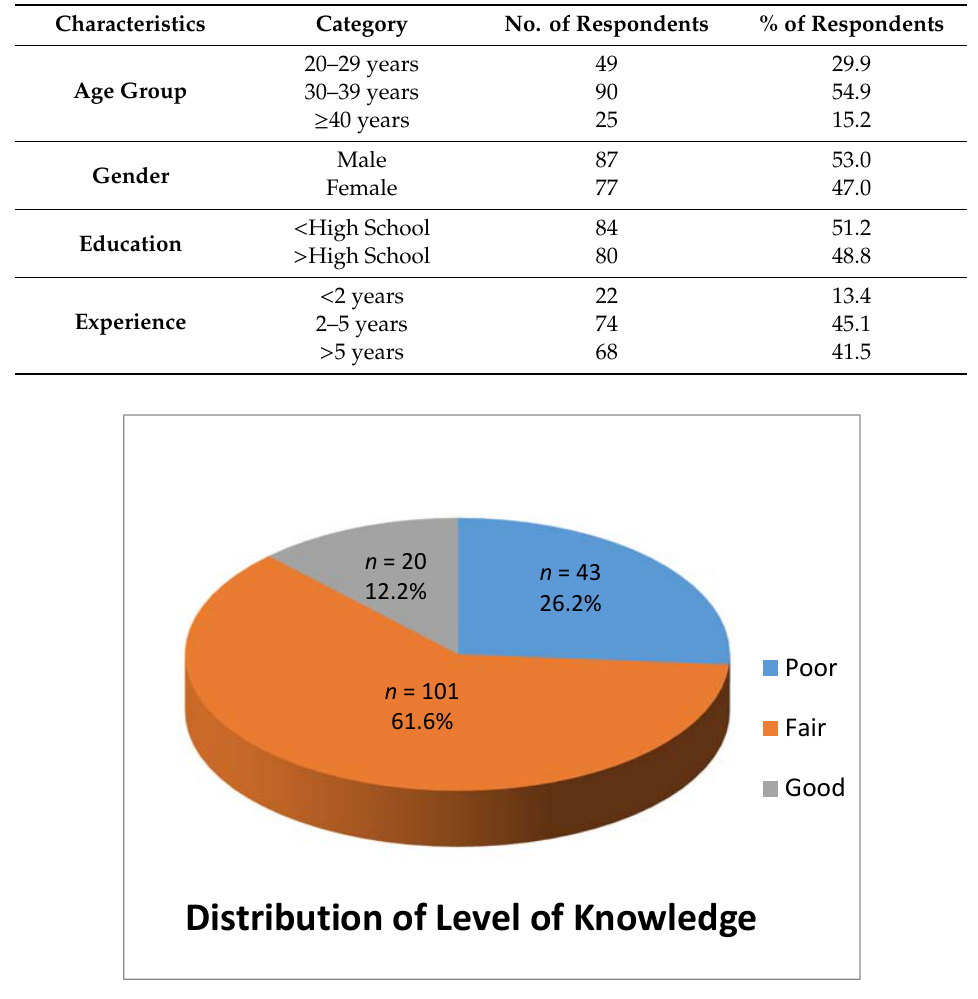
Figure 1. Distribution of level of knowledge among the respondents who participated in the study.